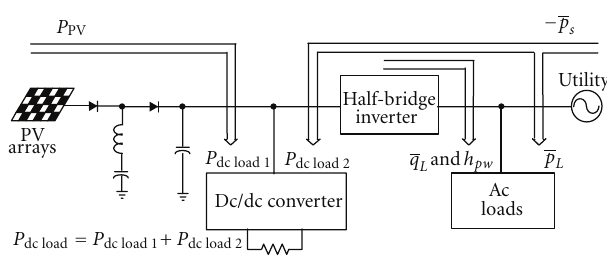
Figure 10: Illustration of power flow during the interval of low insolation.